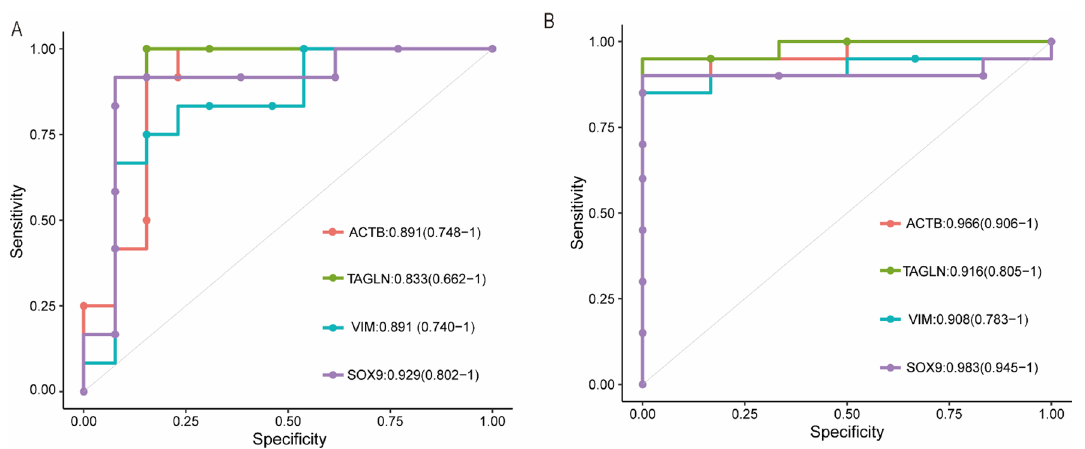
Figure 6. The ROC curve of diagnostic effectiveness of Hub DEGs in cirrhosis ( A , B ) ROC curve of ACTB , TAGLN, VIM and SOX9 in the data of GSE89377 and GSE139602